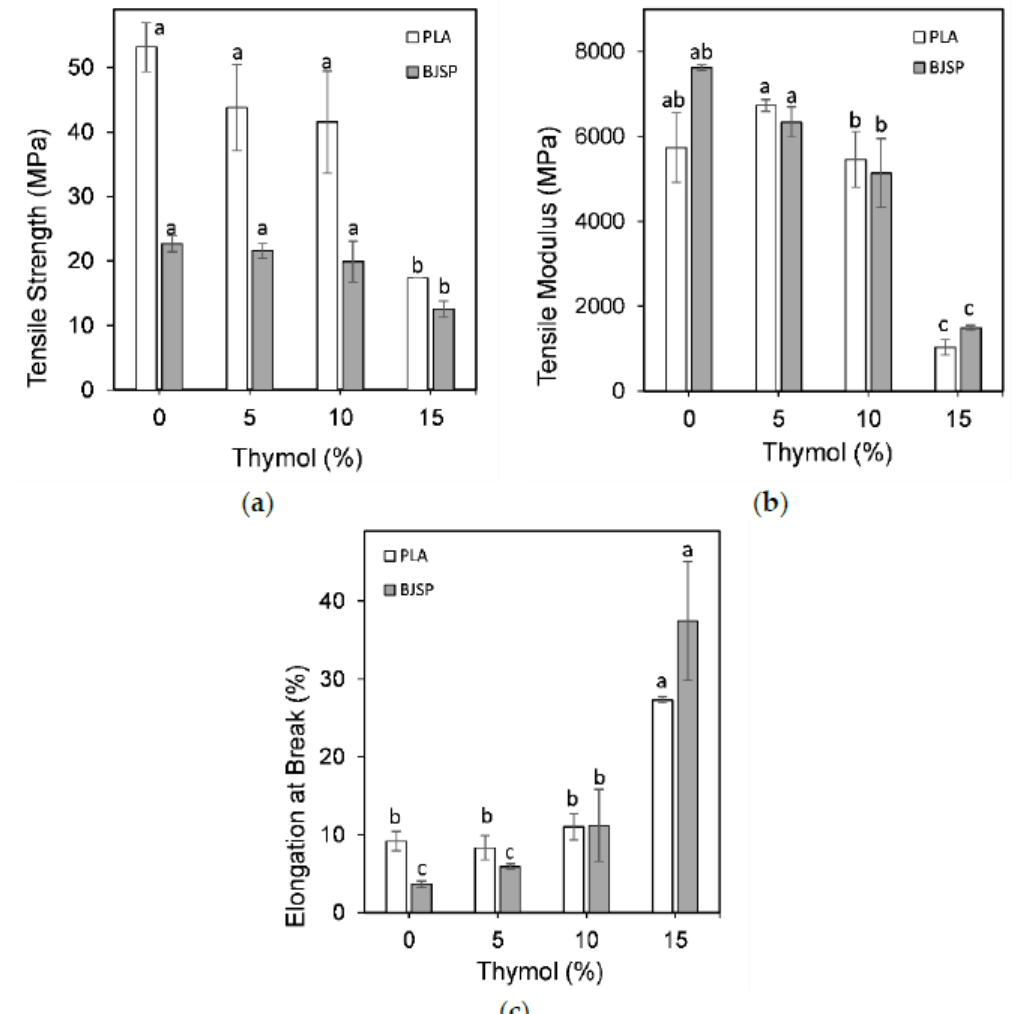
Figure 6. The figure shows the ( a ) tensile strength, ( b ) tensile modulus and ( c ) elongation at break of PLA- and 30BJSP-based composites with di ff erent thymol contents. Data represents mean ± standard deviation of four independent repeats. Di ff erent letters in each thymol loading indicate significant di ff erences ( p <